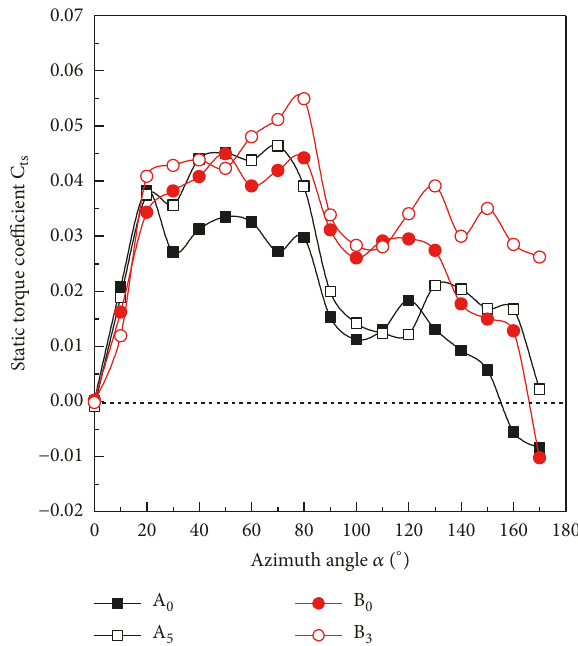
Figure 12: Static torque coefficients in one rotation period.